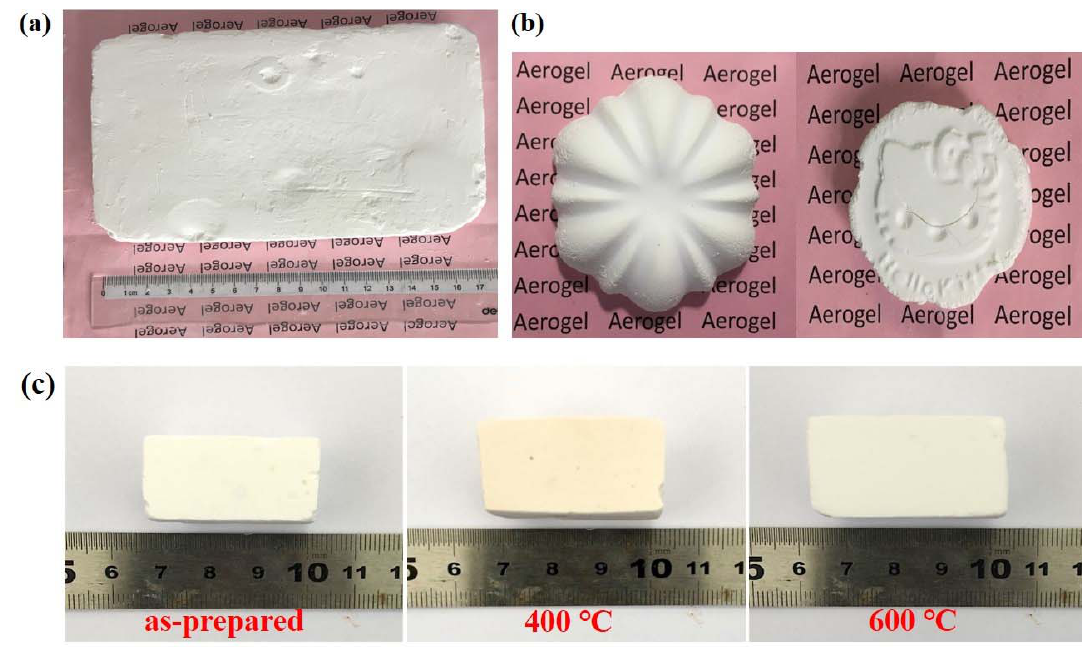
Figure 2. Photographs of typical silica xerogels: ( a ) as-prepared large-sized PEG-1 silica xerogel (17.5 cm × 11 cm × 2.1 cm); ( b ) Cast-in-situ PEG-1 silica xerogel in complex patterns; ( c ) PEG-1 silica xerogel before and after heat treatment at 400 and 600 °C.